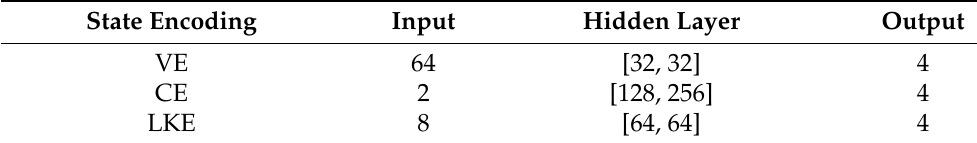
Table 3. The used network architectures for the different state encodings.